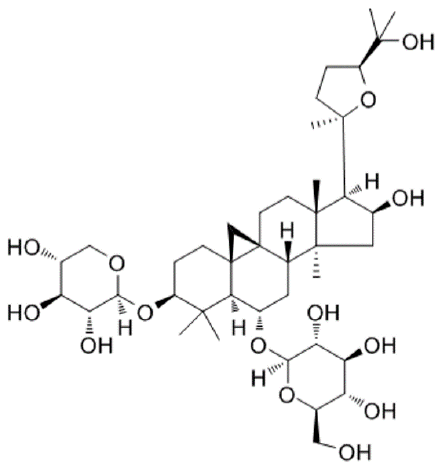
Figure 1. Chemical structure of Astragaloside IV.